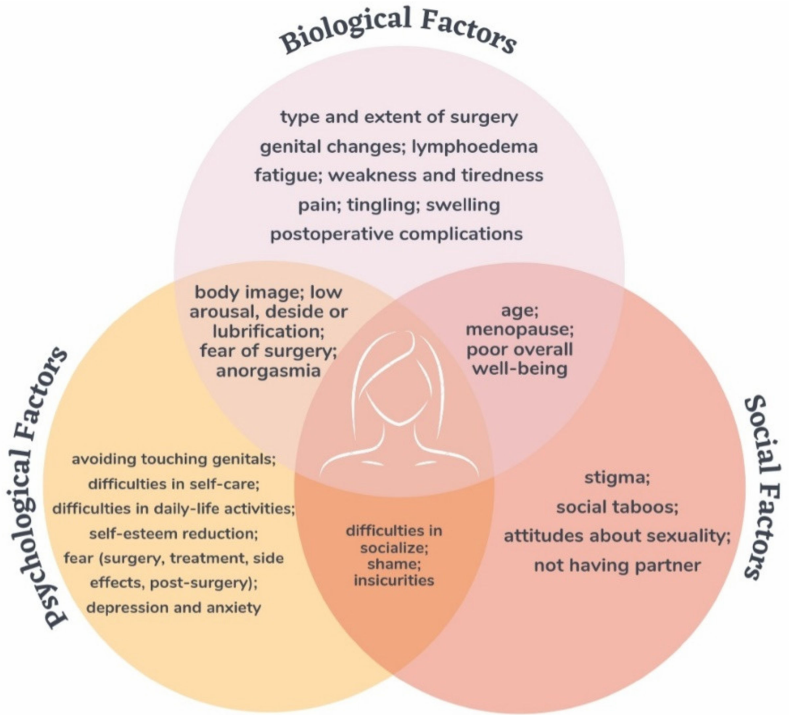
Figure 1. Summary of the results. This figure shows the main bio–psycho–social factors that impact the psychosocial and sexual well-being of women with vulvar